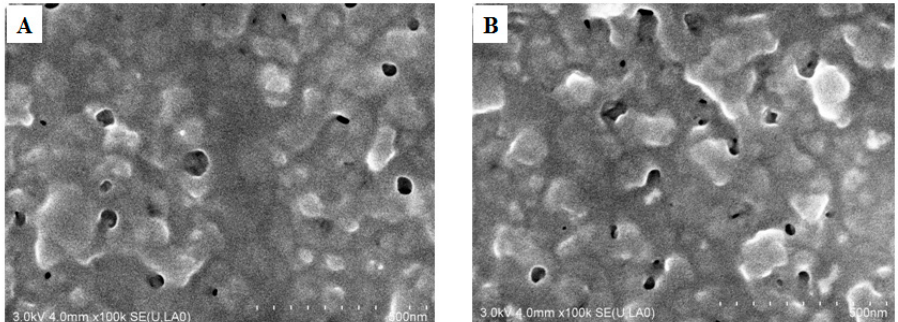
Figure 5. SEM top views of {Con A/GOD} 5 films assembled on PG/PDDA surface after the films were immersed in buffers containing 0.5 mM Fc(COOH) 2 at pH ( A ) 4.0 and ( B ) 8.0 for 30 min, and there is no substantial difference in the structures.